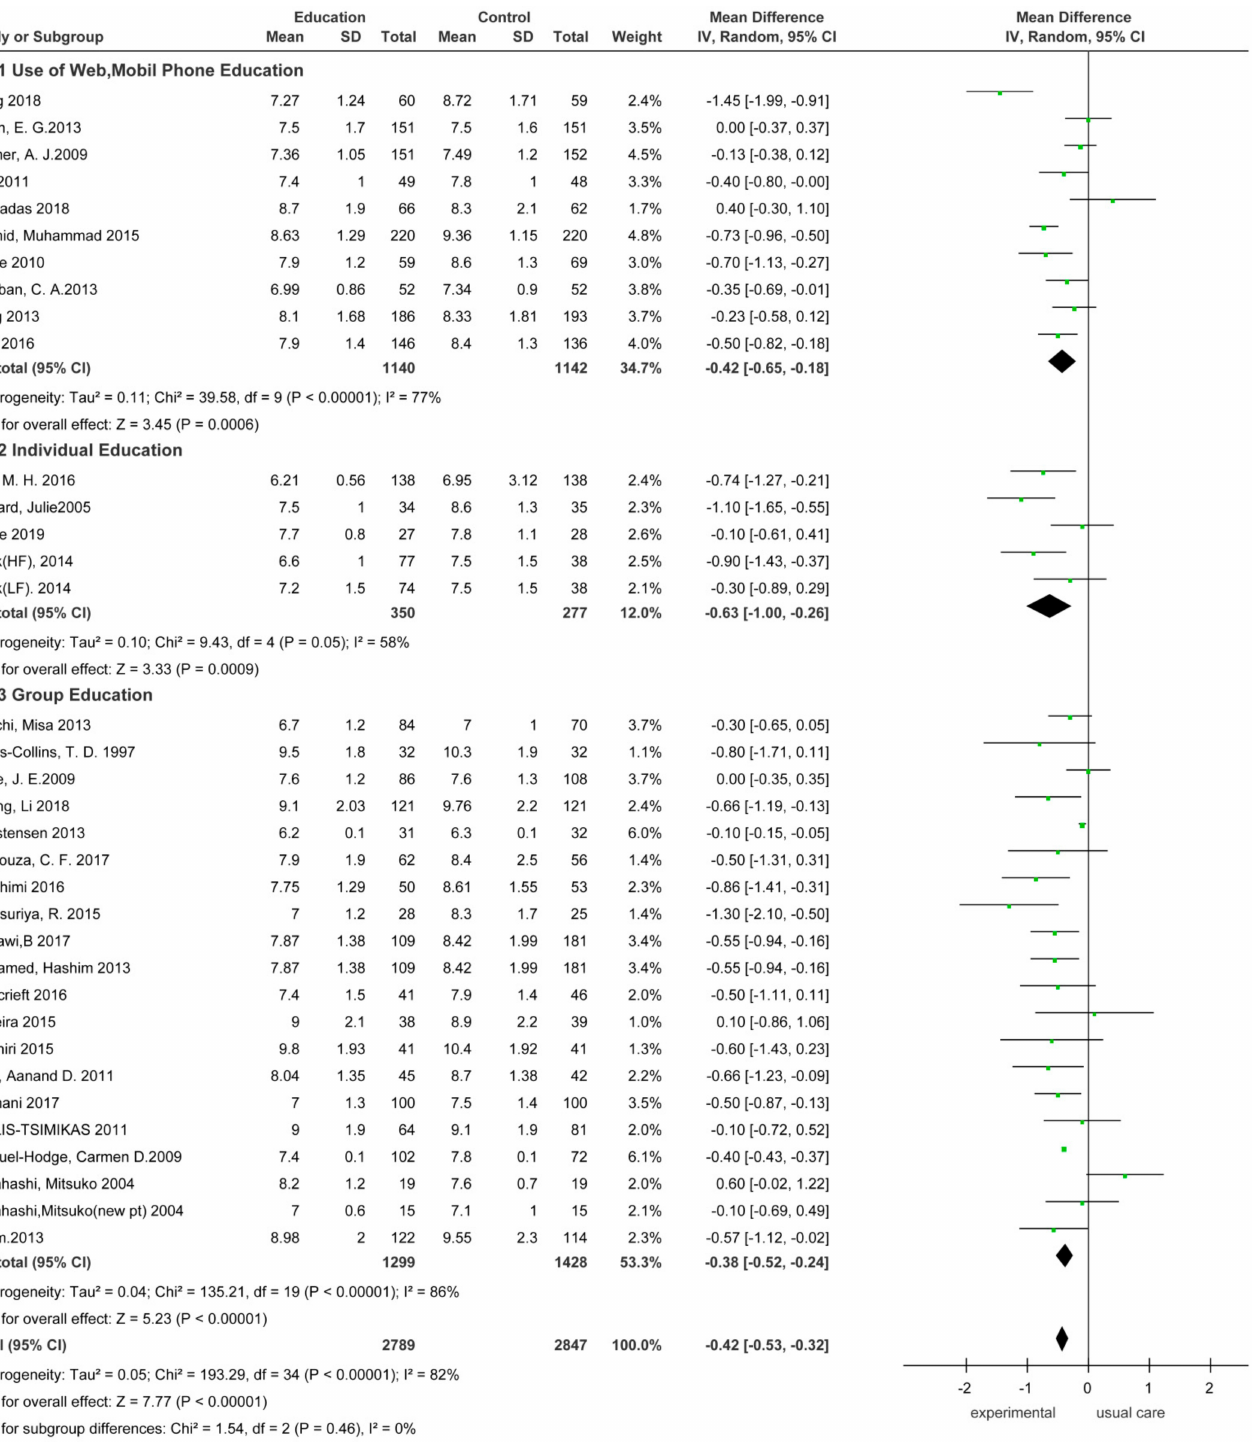
Figure 5. Forest plot of the effect of the intervention method. SD, standard deviation; CI, confidence interval; IV, inverse